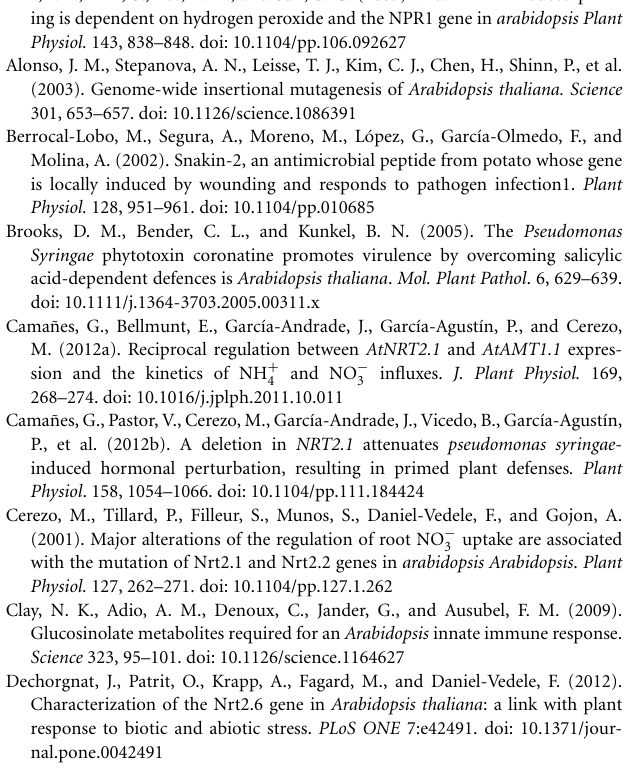
Figure S1 | Heat map analysis performed with Marvis (Filter and Cluster packages). Five and two week old plants either mock ( Col3-gl/1 and amt1.1 ) or either P. syringae Col3-gl/1 P. syringae and amt1.1 P. syringae or P. cucumerina inoculated ( Col3-gl/1 Pc and amt1.1 Pc) plants were processed for relative quantification analysis by HPLC-QTOFMS data. The concentration of the metabolites was determined in all the samples by normalizing the chromatographic area for each compound with the dry weight of the corresponding sample. Heatmaps are generated by using Mar-Vis Filter and Cluster following a Kruskal-Wallys test ( p < 0 . 01). Clusters overepresented amt1.1 mock or infected (intense red colors) compared with wild type plants were selected for subsequent data analysis. Figure S2 | Profile of additional hits in the overaccumulated compounds upon P. cucumerina infection in amt1.1 compared with Col3-gl1. For experimental details see Figures 1 , 9 . The concentration of the metabolites was determined in all the samples by normalizing the chromatographic area for each compound with the dry weight of the corresponding sample. The compounds were tentatively identified using the exact mass criteria using the METLIN and Massbank databases. Those compounds tentatively identified have the exact mass indicated. Te compounds fully identified have no reference to the mass. The compounds were grouped by metabolic pathways according to KEGG and AraCyc databases. White bars are mock inoculated and filled bars are P. cucmerina infected plants. Leaf material from 150 individual plants were pooled together for each treatment × genotype combination. Boxplots represent average three independent experiments with two technical replicates. Only data showing a p -value below 0.01 after a Kuskal wallys test were used for pathway assignation ( n =